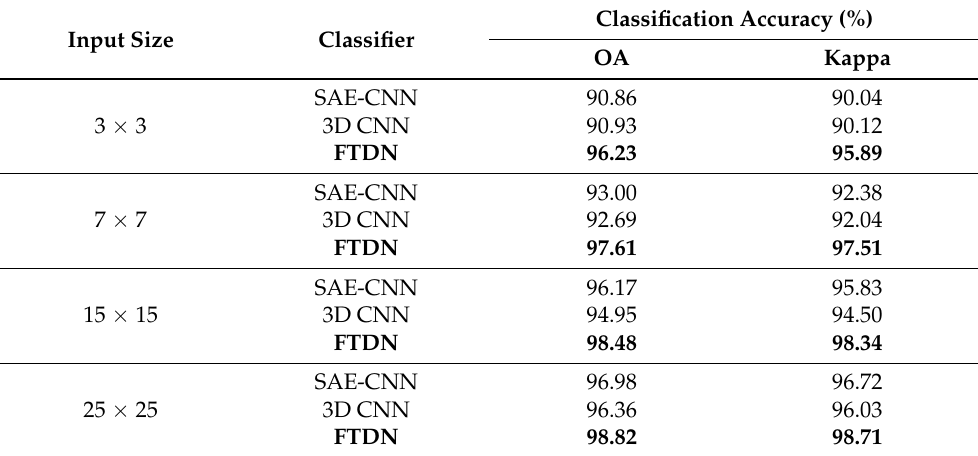
Table 8. Classification performances of different classifiers under different input